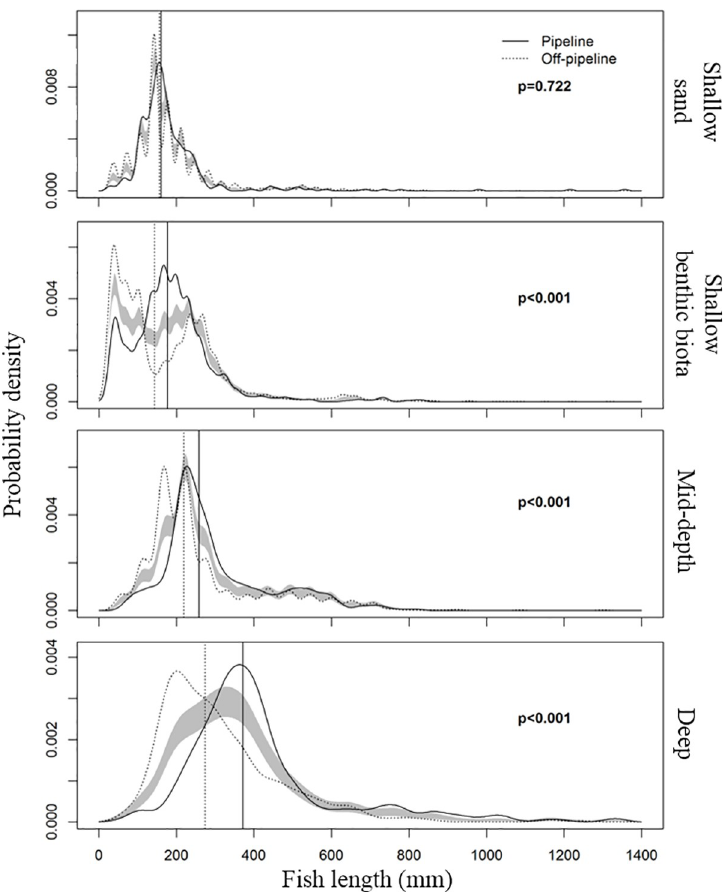
Fig 10. Comparison of the kernel density estimate (KDE) probability function using the mean bandwidth for the lengths of all fish by Location (pipeline and off-pipeline) and depth using raw fish length data. Shallow water deployments are divided into ‘sand’ or ‘benthic biota’ determined by the dominant habitat seen on video footage. Solid and dotted lines present the KDE probability density functions that approximate the length-frequency data of all fish on and off-pipeline, respectively. The shaded band represents 1 SE either side of the null model of no difference between either KDE for each Location. Significance was based on permutation tests of the area between the probability density functions. Vertical lines represent the median fish length from all fish measured on and